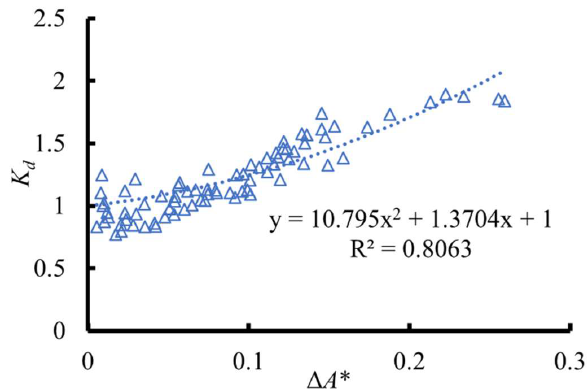
Figure 13. Correlation between the equilibrium blockage ratio, ∆ A ∗ , and K d